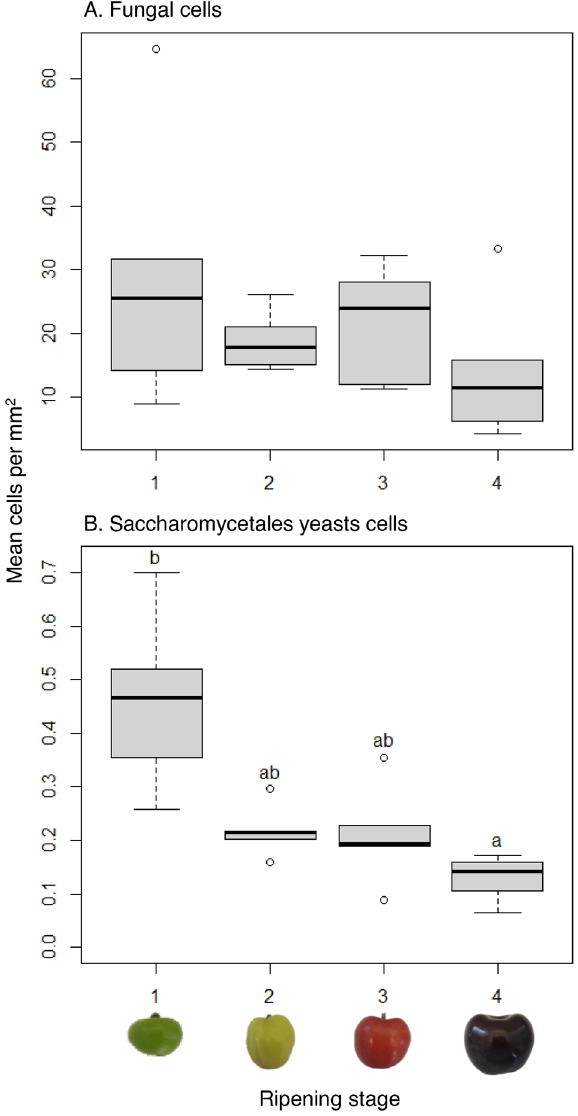
stages (1, unripe/green fruit; 2, de-greening fruit; 3, ripening fruit; and 4, fully ripe/harvest fruit) estimated from DNA read abundances normalised to DNA abundances from the deliberate addition of 265 live Plectosphaerella cucumerina cells prior to DNA extraction. Different lower-case letters above bars show significant differences between ripening stages at P > 0.05, Dunn’s comparisons post-hoc with Benjamini–Hochberg multiple comparison